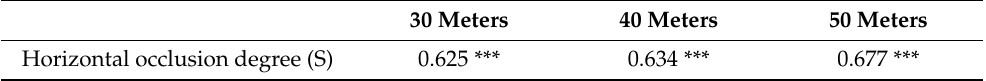
Table 4. Correlation analysis of the horizontal occlusion degree under three lengths.